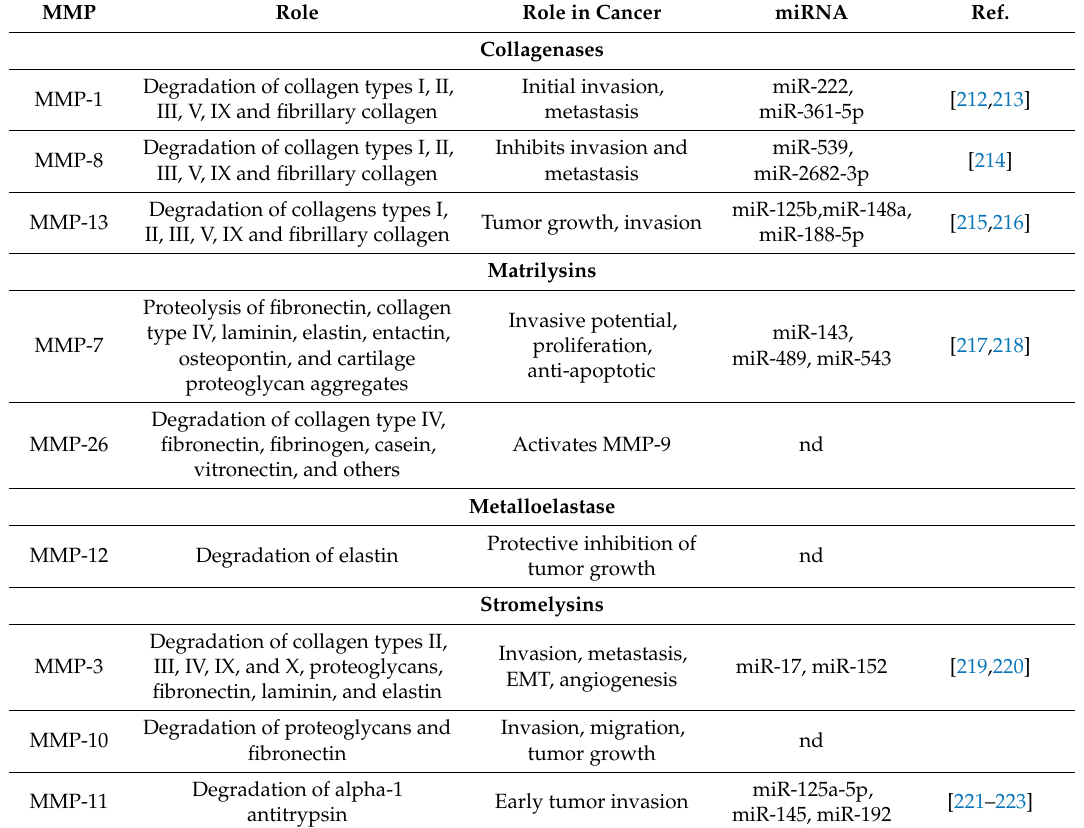
Table 4. Direct regulation of matrix metalloproteinases (MMPs) by miRNAs in cancer cells. MMP Role Role in Cancer miRNA Ref.